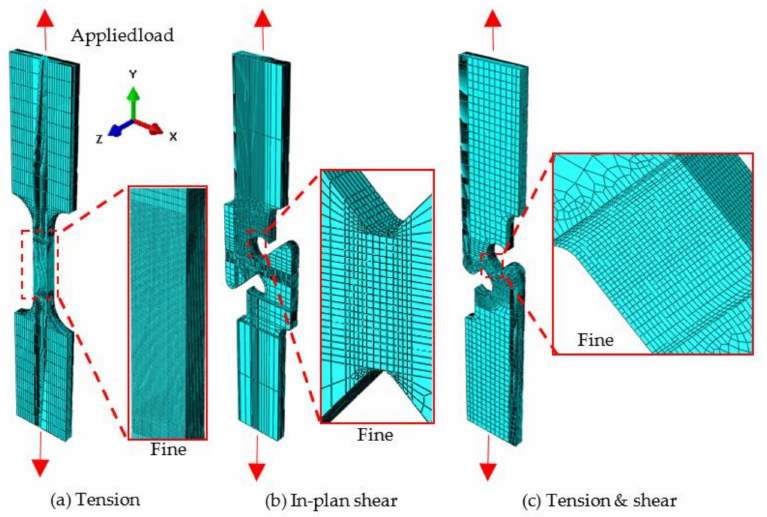
Figure 4. FE models: ( a ) Uniaxial tension specimen; ( b ) In-plane shear specimen; ( c ) Tension and shear